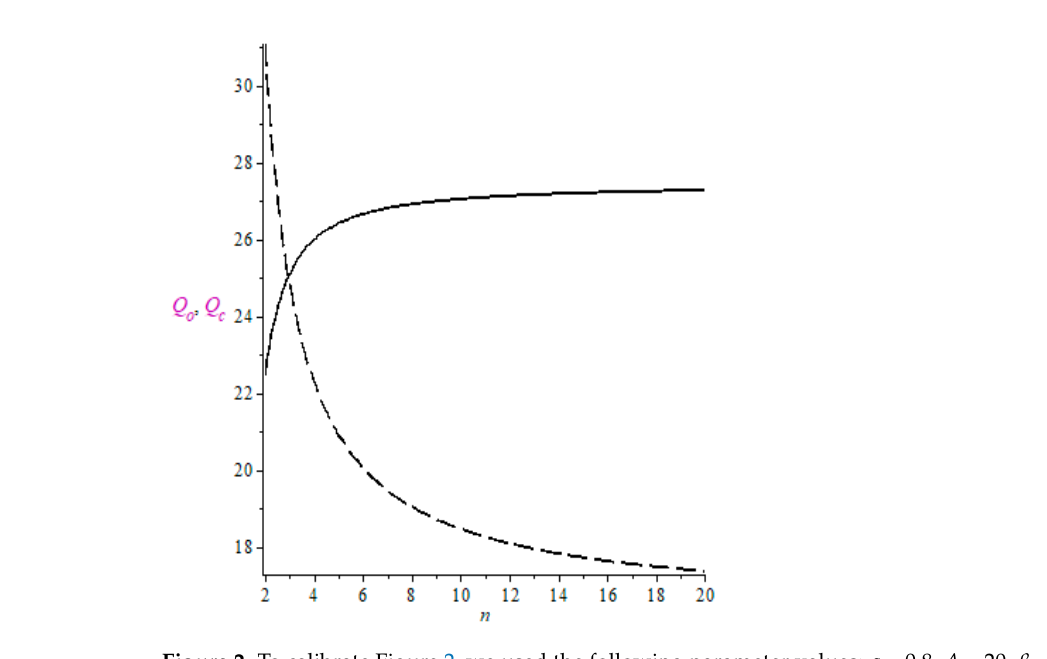
Figure 1. For the calibration, we used the following parameter values: (cid:1869) = 0.8 , (cid:1827) = 20 , (cid:2010) = 0.09 , and (cid:2009) = 0.43 .